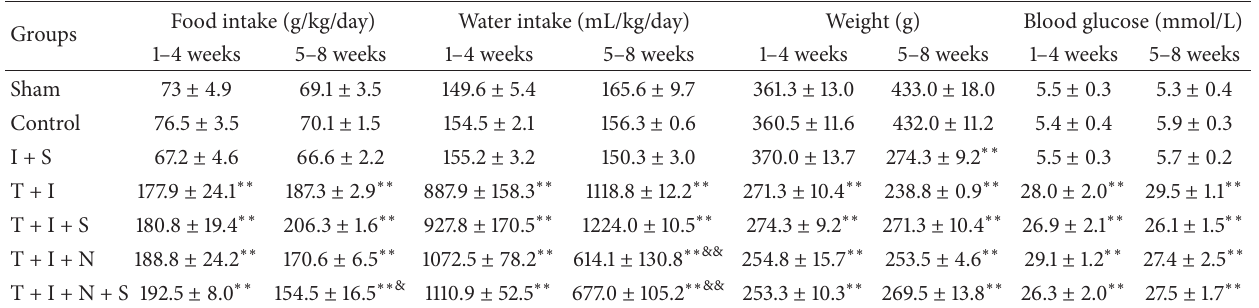
Table 1: General parameters during feeding period.